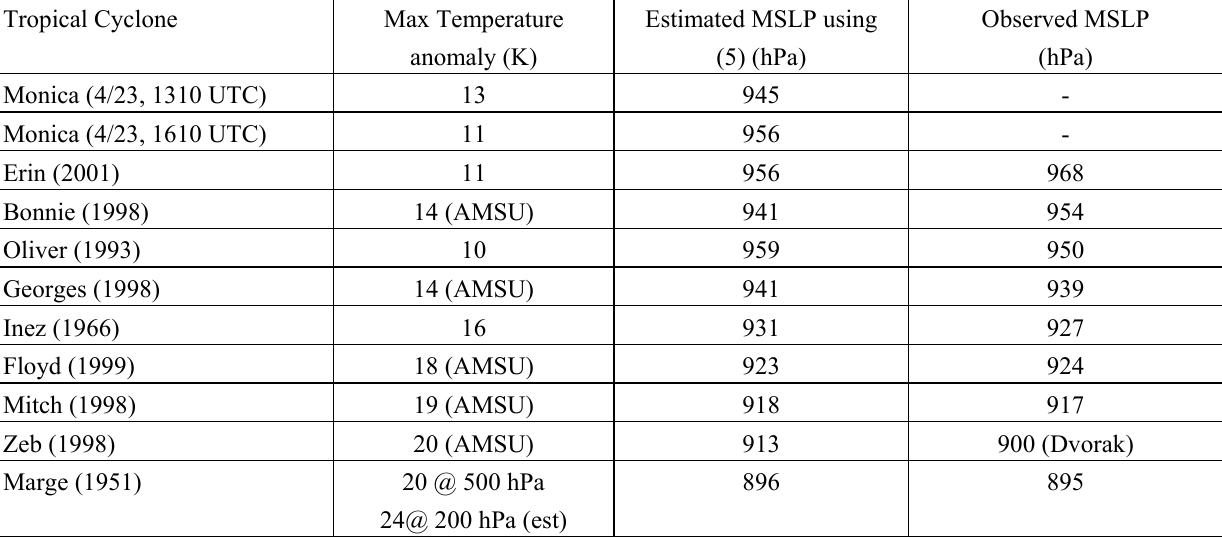
Table 3. MSLP estimated from simplified model using temperature anomaly as